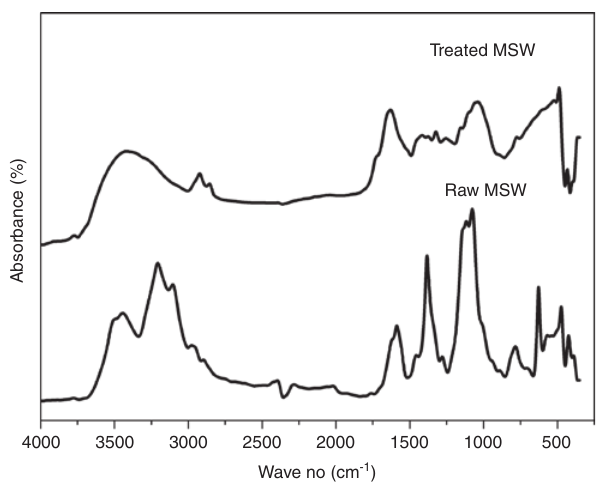
Figure 5 FTIR of raw and treated MSW.